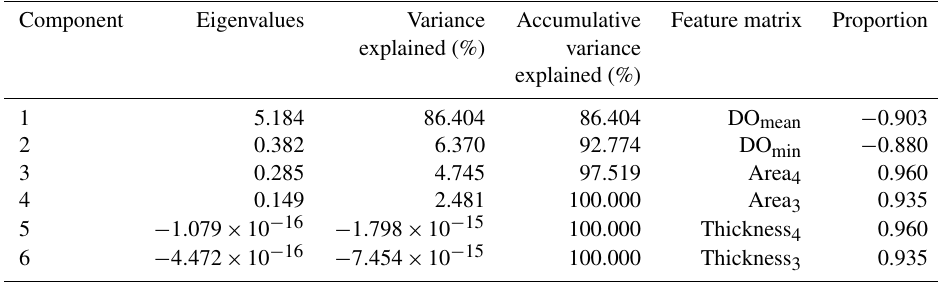
Table A2. Total variance explained and the feature matrix of the first component in the